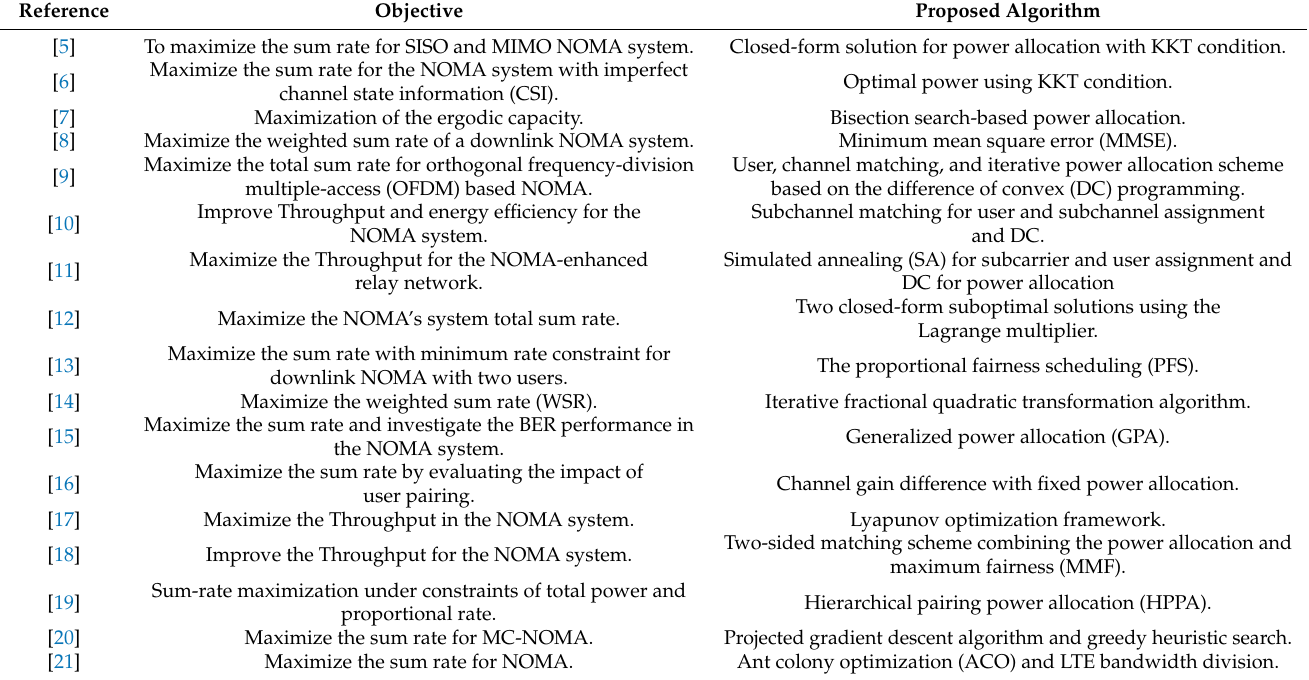
Table 1. Literature Review